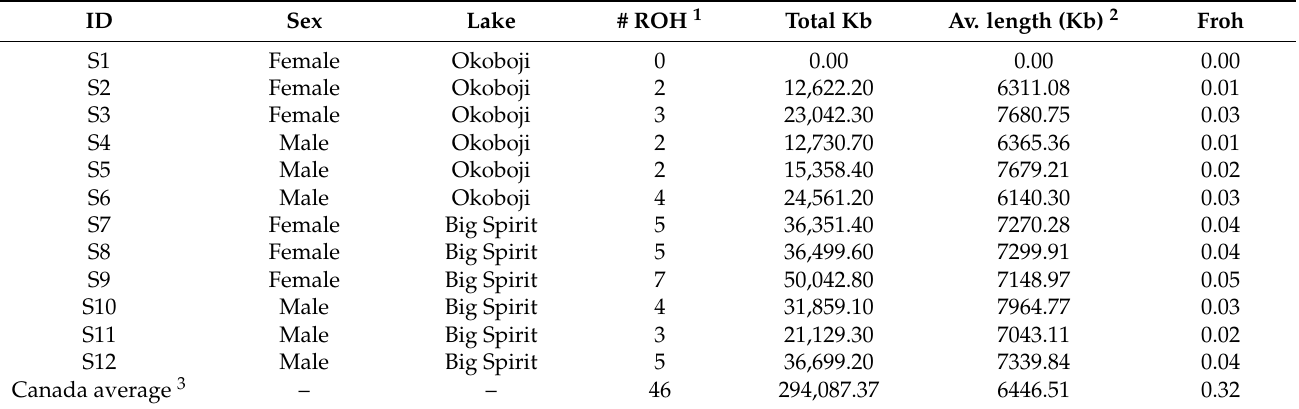
Table 5. Individual and average Froh scores.